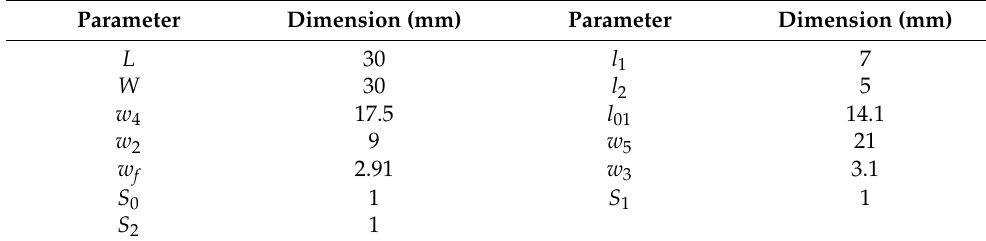
Table 2. Final dimensions of the proposed graphene